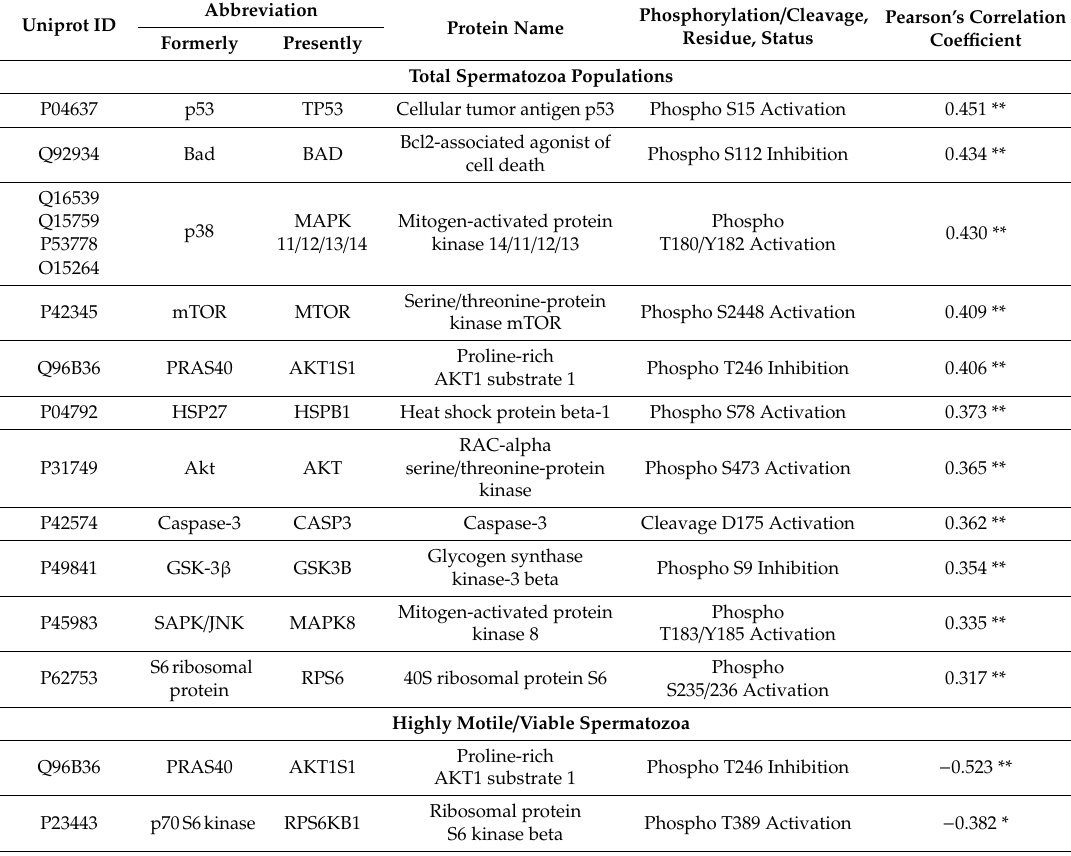
Table 1. Pearson’s correlation coe ffi cients between age and the activity patterns of signaling proteins in human